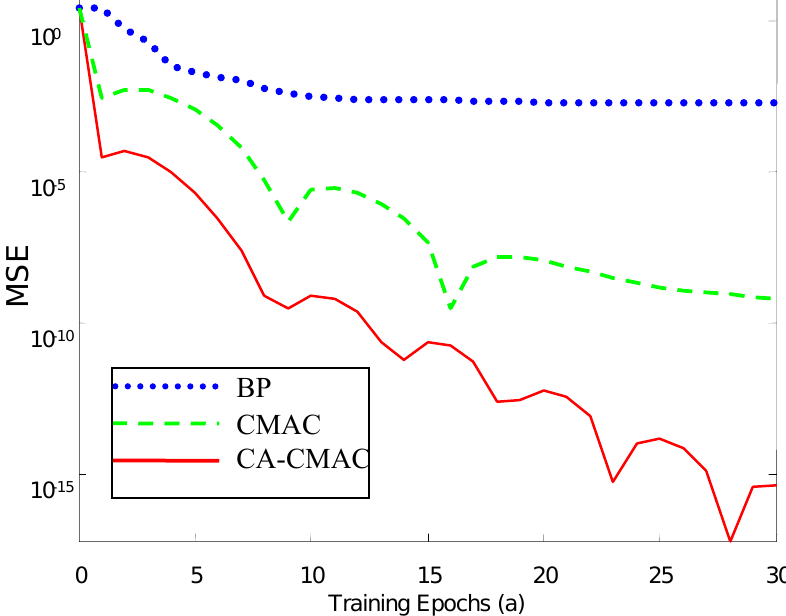
Figure 11. MSE decline curve in the training course of predicting the principal component